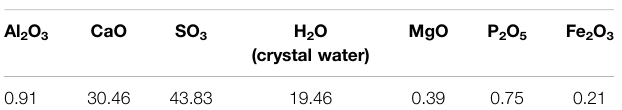
TABLE 1 | Chemical components of PG/%.